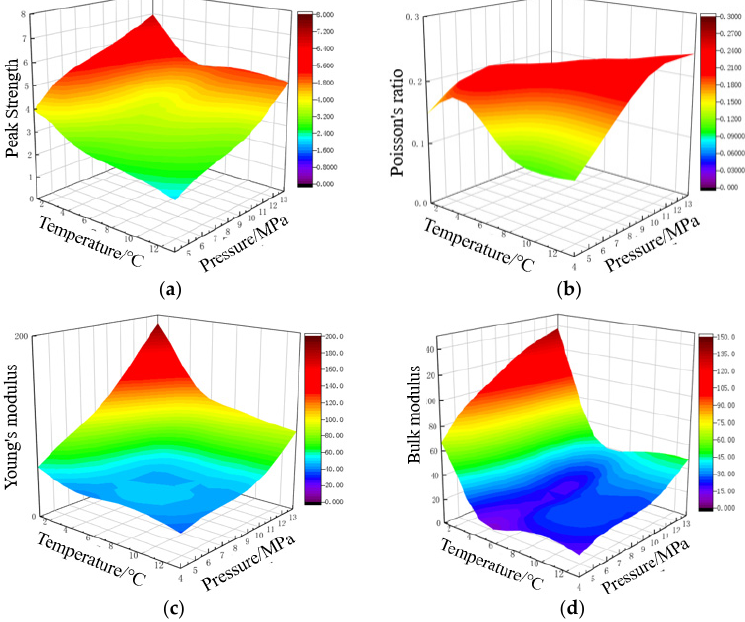
Figure 14. Variation of mechanical properties of sandy hydrate with temperature and pressure ( a ) Peak Strength; ( b ) Poisson’s ratio; ( c ) Young’s modulus; ( d ) Bulk modulus.